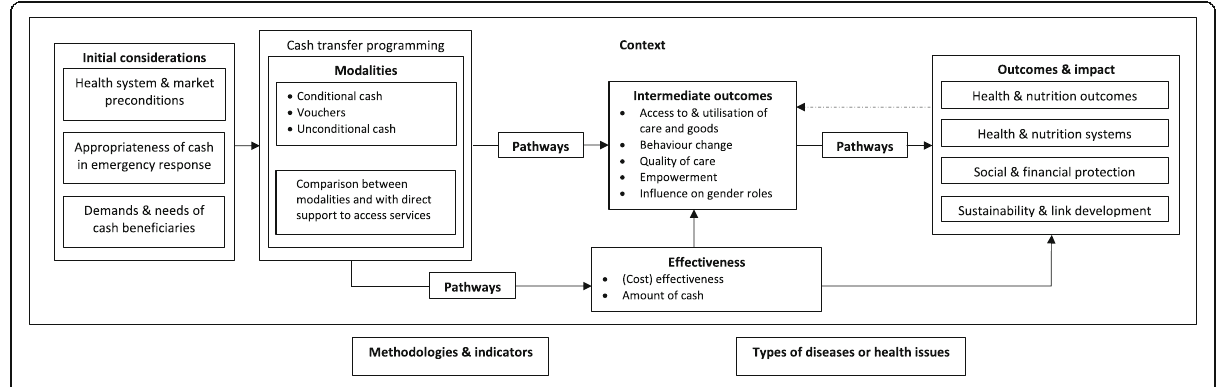
Fig. 2 Overview of our understanding of the relationships between the identified categories